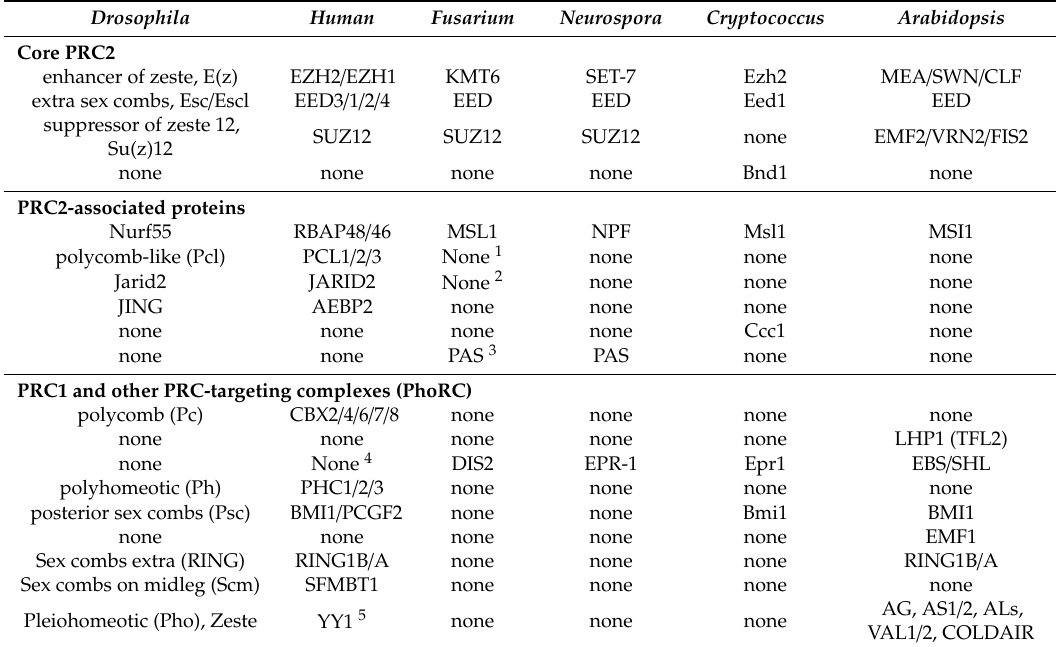
Table 1. Components of polycomb repressive complexes (PRC) in fungi . Known components from Drosophila , human, Fusarium graminearum , Neurospora crassa, Cryptococcus neoformans , and Arabidopsis thaliana . All fungi examined to date have single homologues of at least two core PRC2 subunits (KMT6 and EED). SUZ12 and PRC2-associated subunits, such as MSL1 / NPF or PAS appear more